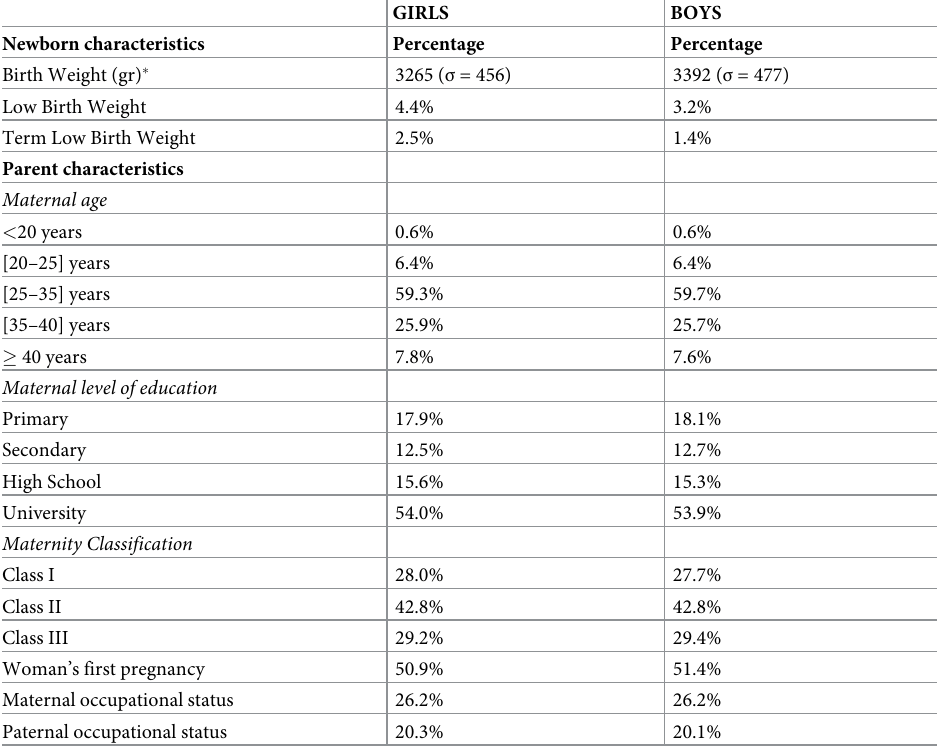
Table 1. Descriptive statistics for the